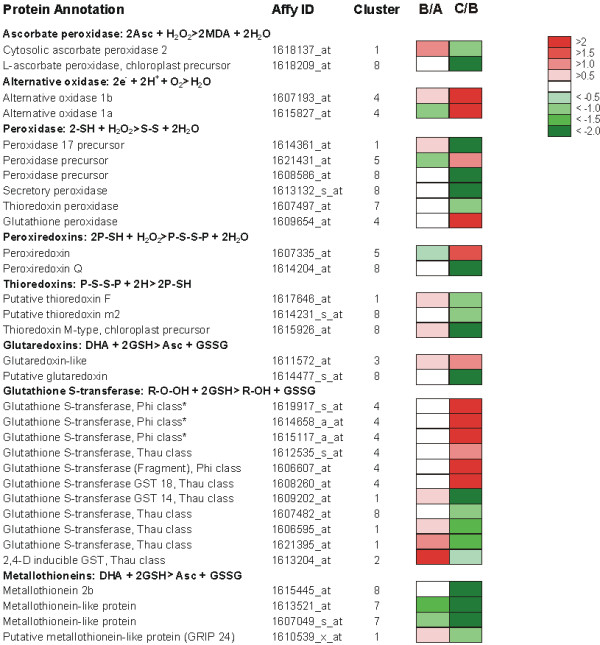
Genes involved in the response to oxidative stress modulated during ripening. List of the ROS-scavenging genes found in the modulated core set and comparative analysis of their expression in the three sampling TPs. Log2 ratios of the expression values observed in TPs A, B and C (B/A and C/B) are visualized by a colour scale, where red indicates an increase and green a decrease. For each functional group the corresponding enzymatic reaction is reported. * refer to probesets probably corresponding to the same transcript.